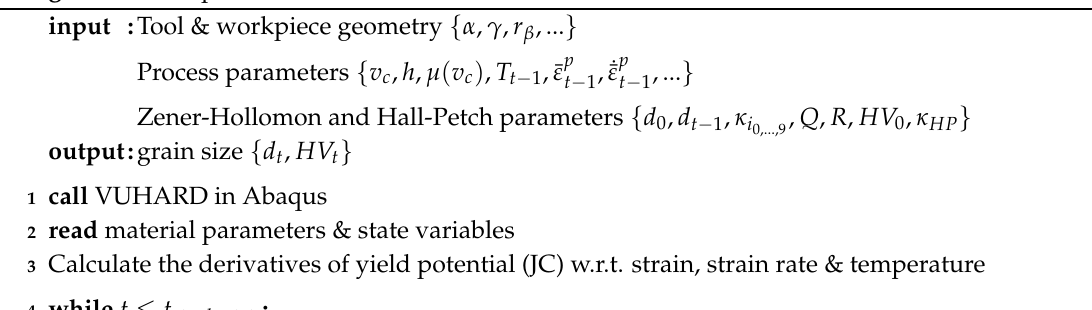
Algorithm 1: Implementation of Zener-Hollomon DRX